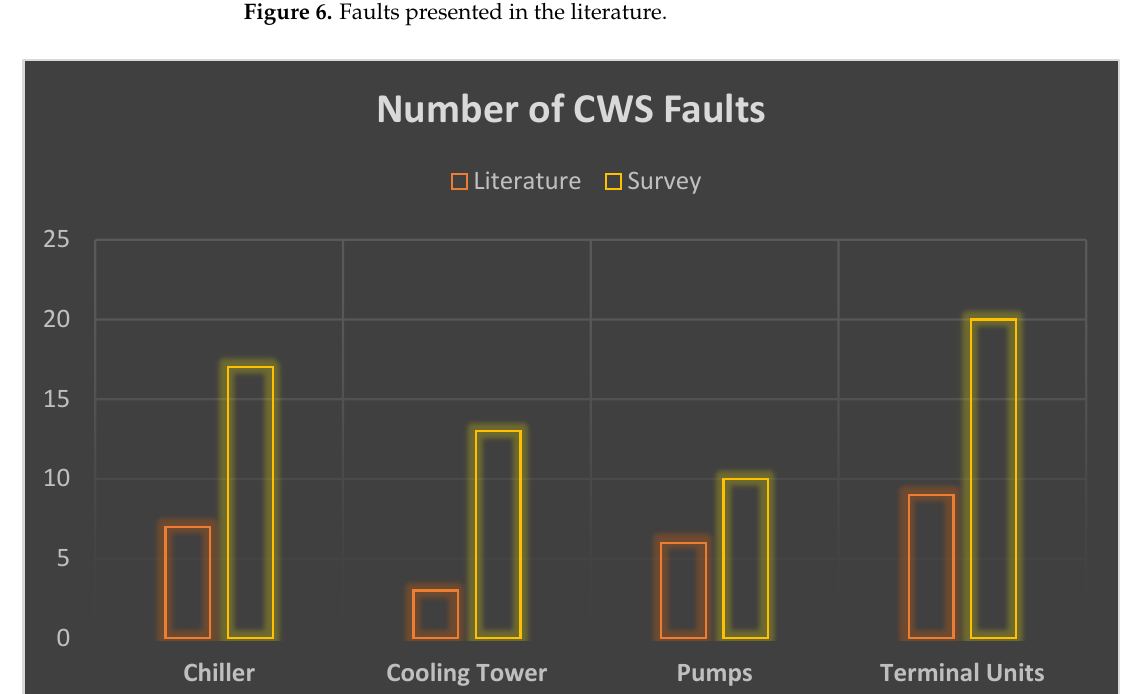
Figure 7. Difference in faults number. Figure 7.